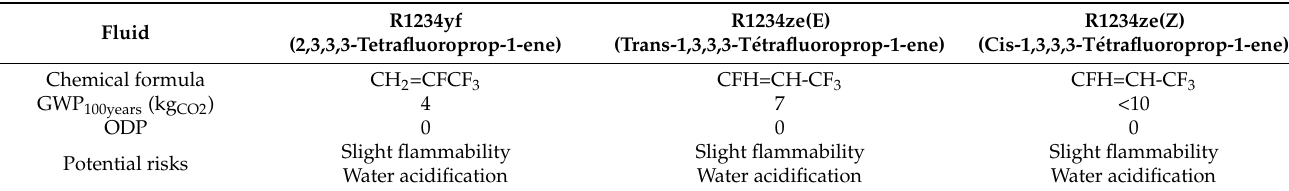
Table 3. Characteristics of HFOs R1234yf, R1234ze(E) and R1234ze(Z). R1234yf R1234ze(E) Fluid (2,3,3,3-Tetrafluoroprop-1-ene) (Trans-1,3,3,3-T é trafluoroprop-1-ene)